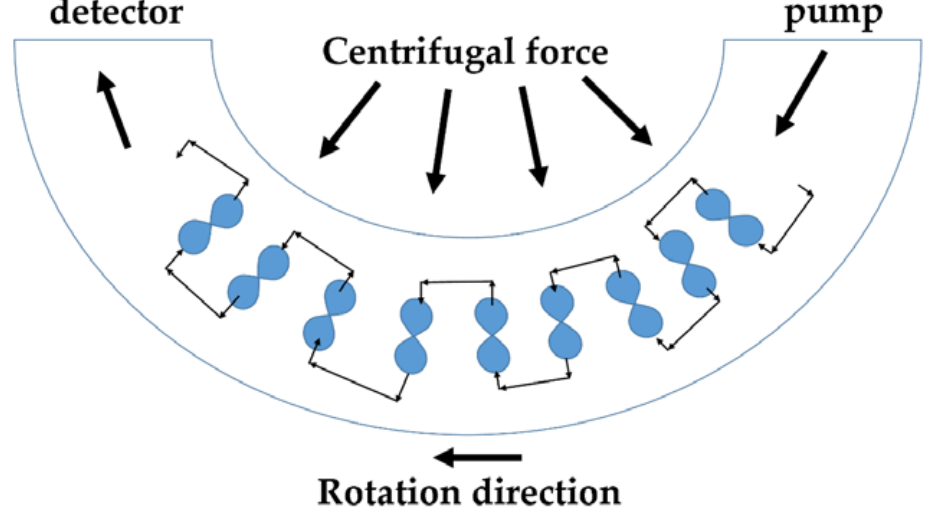
Figure 10. Centrifugal Partition Chromatography: a preparative scale method for plant extract fractionation. Table 1. Application of plant extracts in food